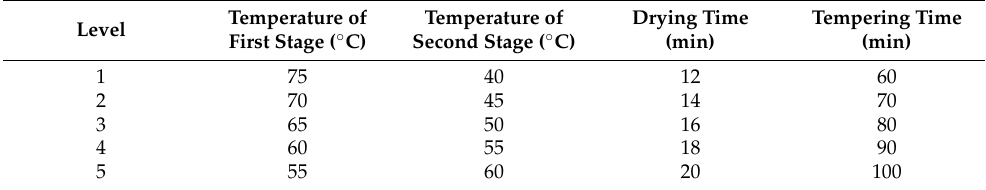
Table 1. Independent variables and actual levels used in single factor experiment